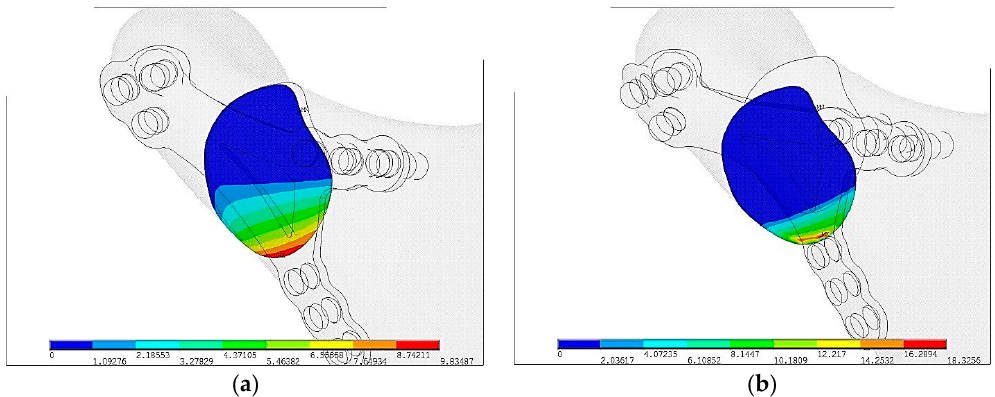
Figure 5. Displacements of pressure in mandibular bone ends just after plate fixation in the maximal loading according to the literature [16]: ( a ) Ti-6Al-4V plate fixation, p max = 9.8 MPa, ( b ) PLLA plate fixation, p max = 18.3 MPa.